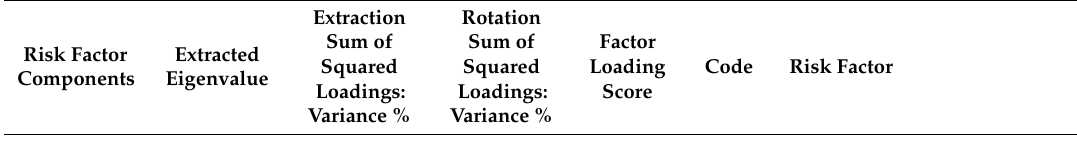
Table 4. Summary of factor analysis for risk factor